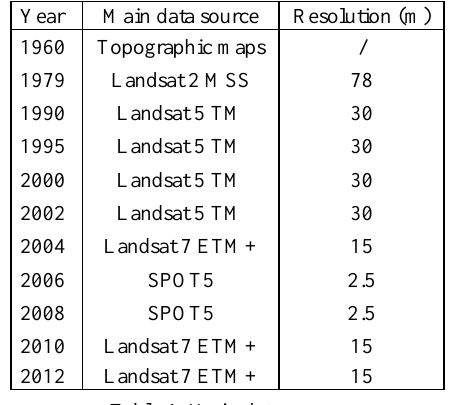
Table 1. Main data source